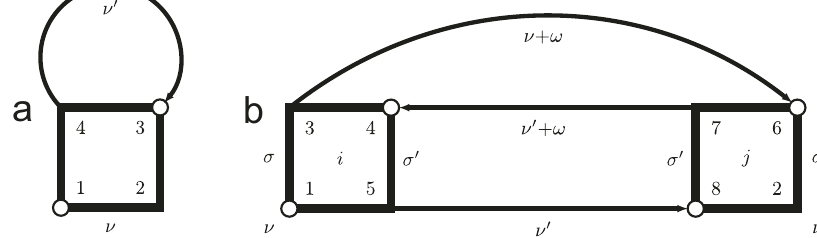
Fig. 8 Dual self-energy. Feynman diagram for the fi rst order ( a ) and the second order ( b ) dual fermion perturbation for the self-energy e Σ 12 ð ν Þ : a line represents the non-local dual Green ’ s function e G 43 ð ν 0 Þ and a box is the local plaquette vertex γ 1234 , ð σ ; σ 0 Þ are